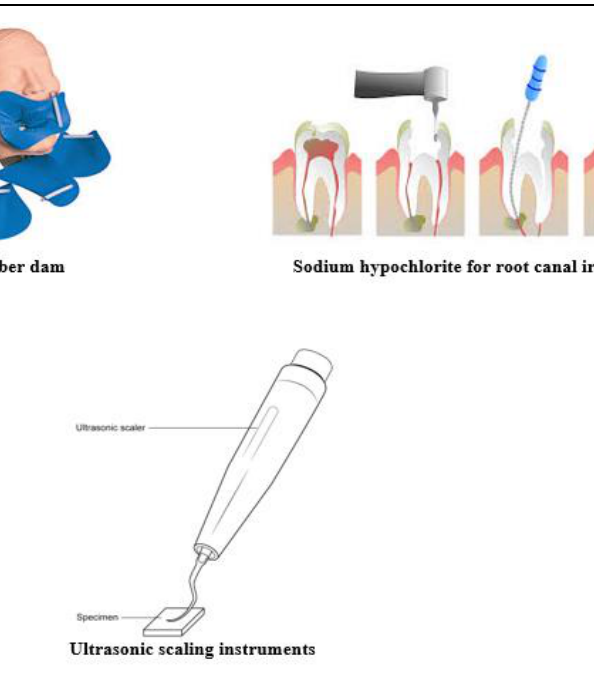
Figure 3. Recommendation to manage a dental emergency in the course of